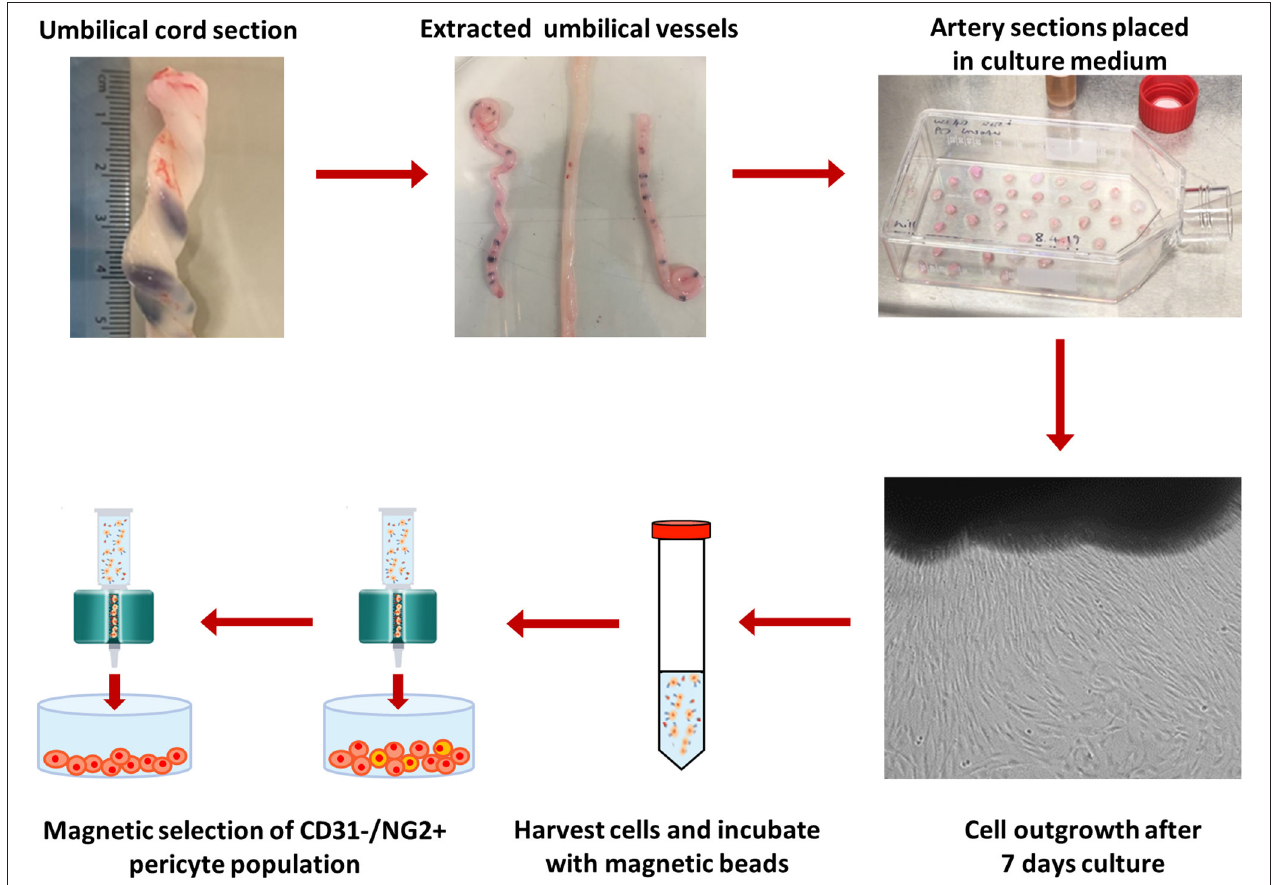
FIGURE 1 | Protocol for isolation of NG2 UCPs. Umbilical vessels were extracted from the cord and the Wharton’s Jelly removed. 1–3 mm 2 sections of the umbilical artery were placed in a flask and cultured in EGM-2. After 7–10 days, the tissue sections were removed, and migrated cells were collected. The cells were sorted to obtain an NG2 + /CD31 − pericyte population using immunomagnetic selection. The purified cell population was cultured in EGM-2 and expanded for further